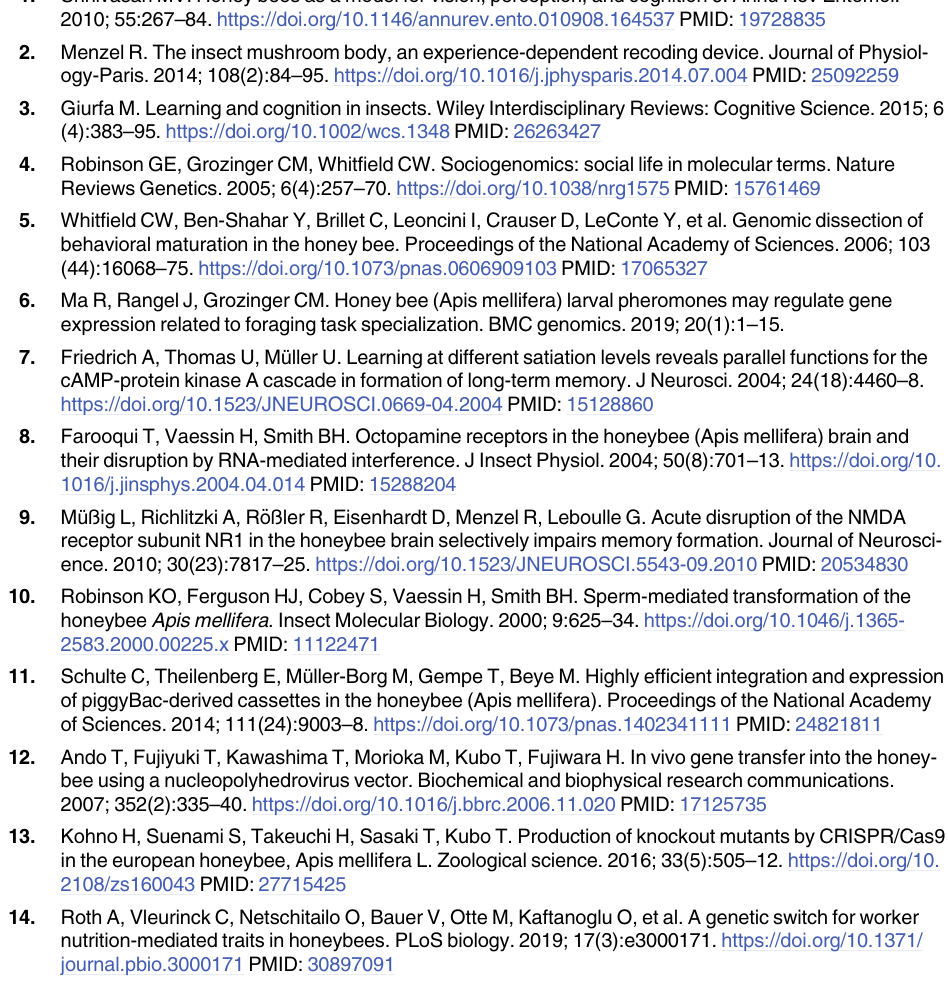
S4 Fig. Proximal part of the axon. The exposition of the slides of Fig 5 to higher excitation shows the proximal part of the axon connecting the cell body.